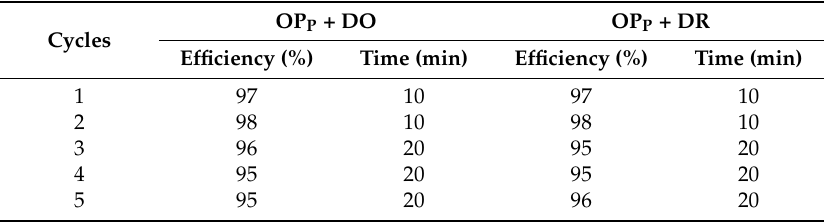
Table 2. Effect of consecutive cycles of DO and DR dye adsorption on contact time evaluated fixing the OP P amount (1.00 g) and ensuring the maximum uptake of dyestuffs from aqueous/acetic